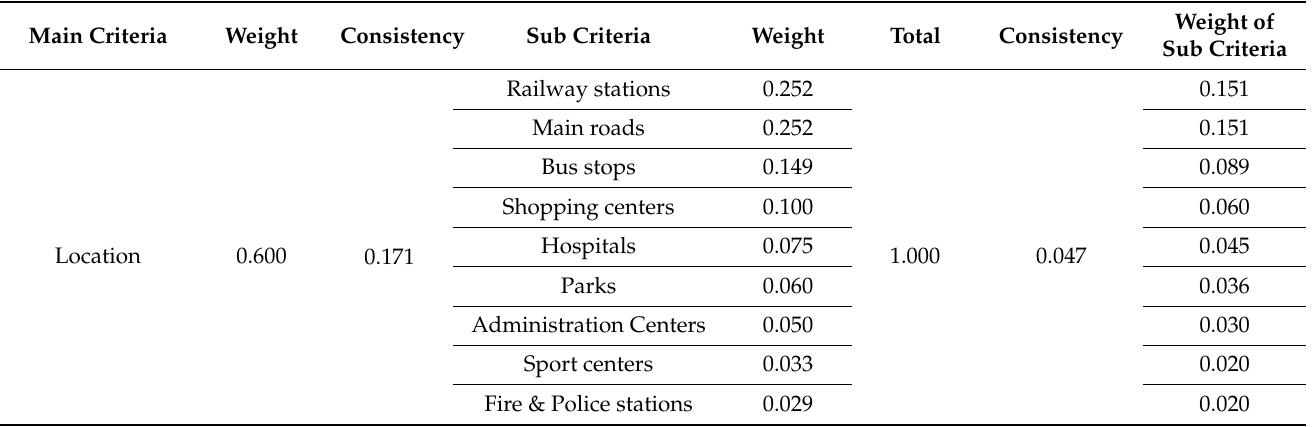
Table 4. Weight of the